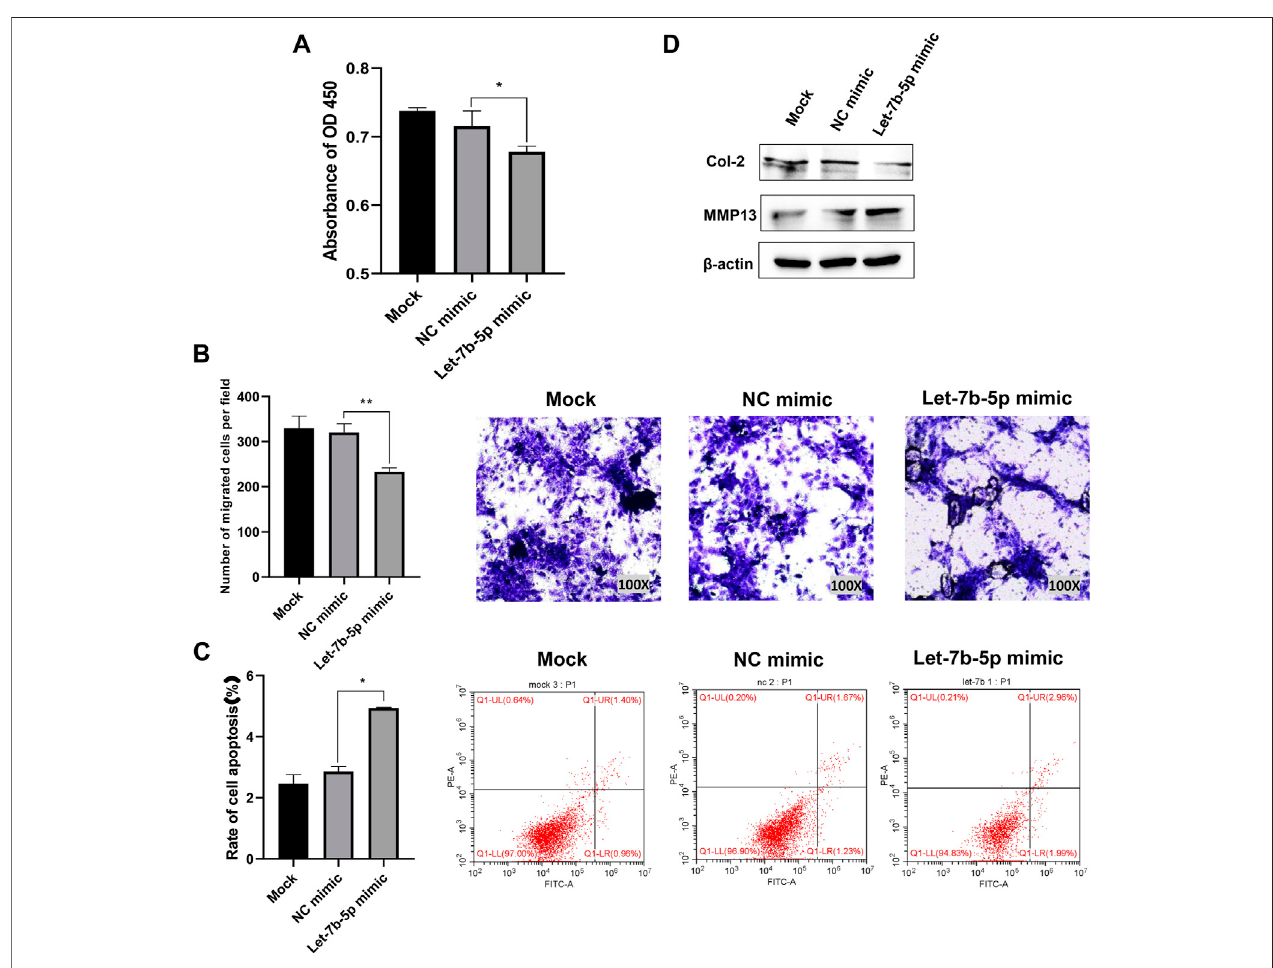
FIGURE 4 | Overexpression of let-7b-5p inhibited proliferation, migration, and extracellular matrix synthesis, and promoted apoptosis of AFCs. AFCs were transfectedwithlet-7b-5pmimic,NCmimic,orPBS(mockgroup). (A) Let-7b-5pmimicinhibitedcellproliferationofAFCsbyCCK-8assay. (B) Let-7b-5pmimicinhibited cellmigrationofAFCsbyTranswellassay. (C) Let-7b-5pmimicpromotedcellapoptosisofAFCsbyAnnexinV/PIapoptosisdetectionkit. (D) Let-7b-5pmimicpromoted the expression of MMP13 and inhibits the expression of Col II by Western blotting. * p < 0.05; ** p <